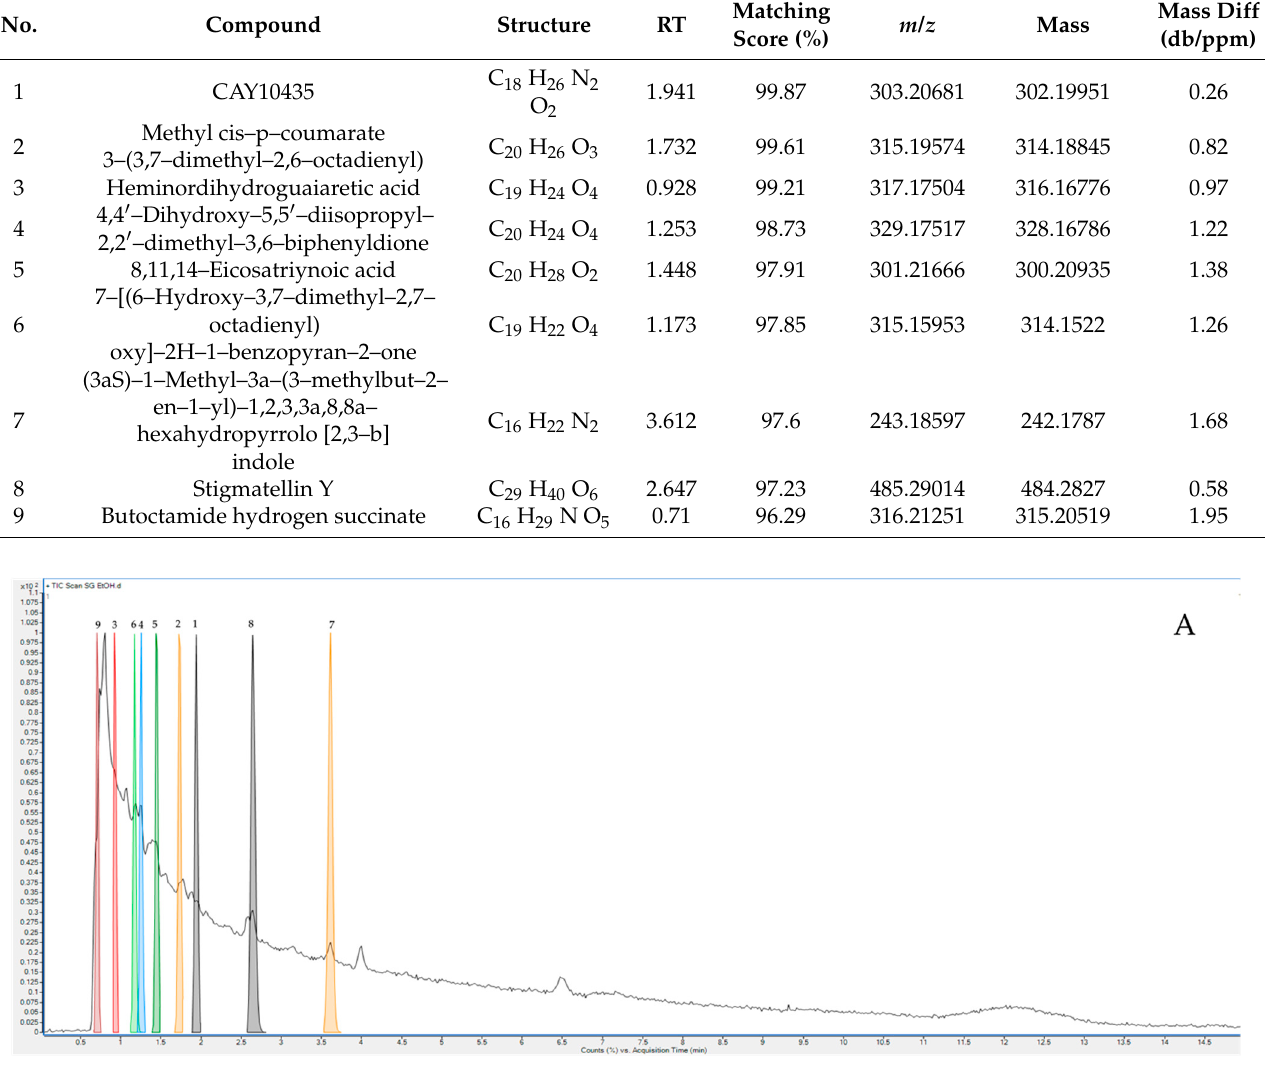
Table 2. Compounds identified from the ethanolic extract of S. glabra crude according to LC-QTOF- MS .